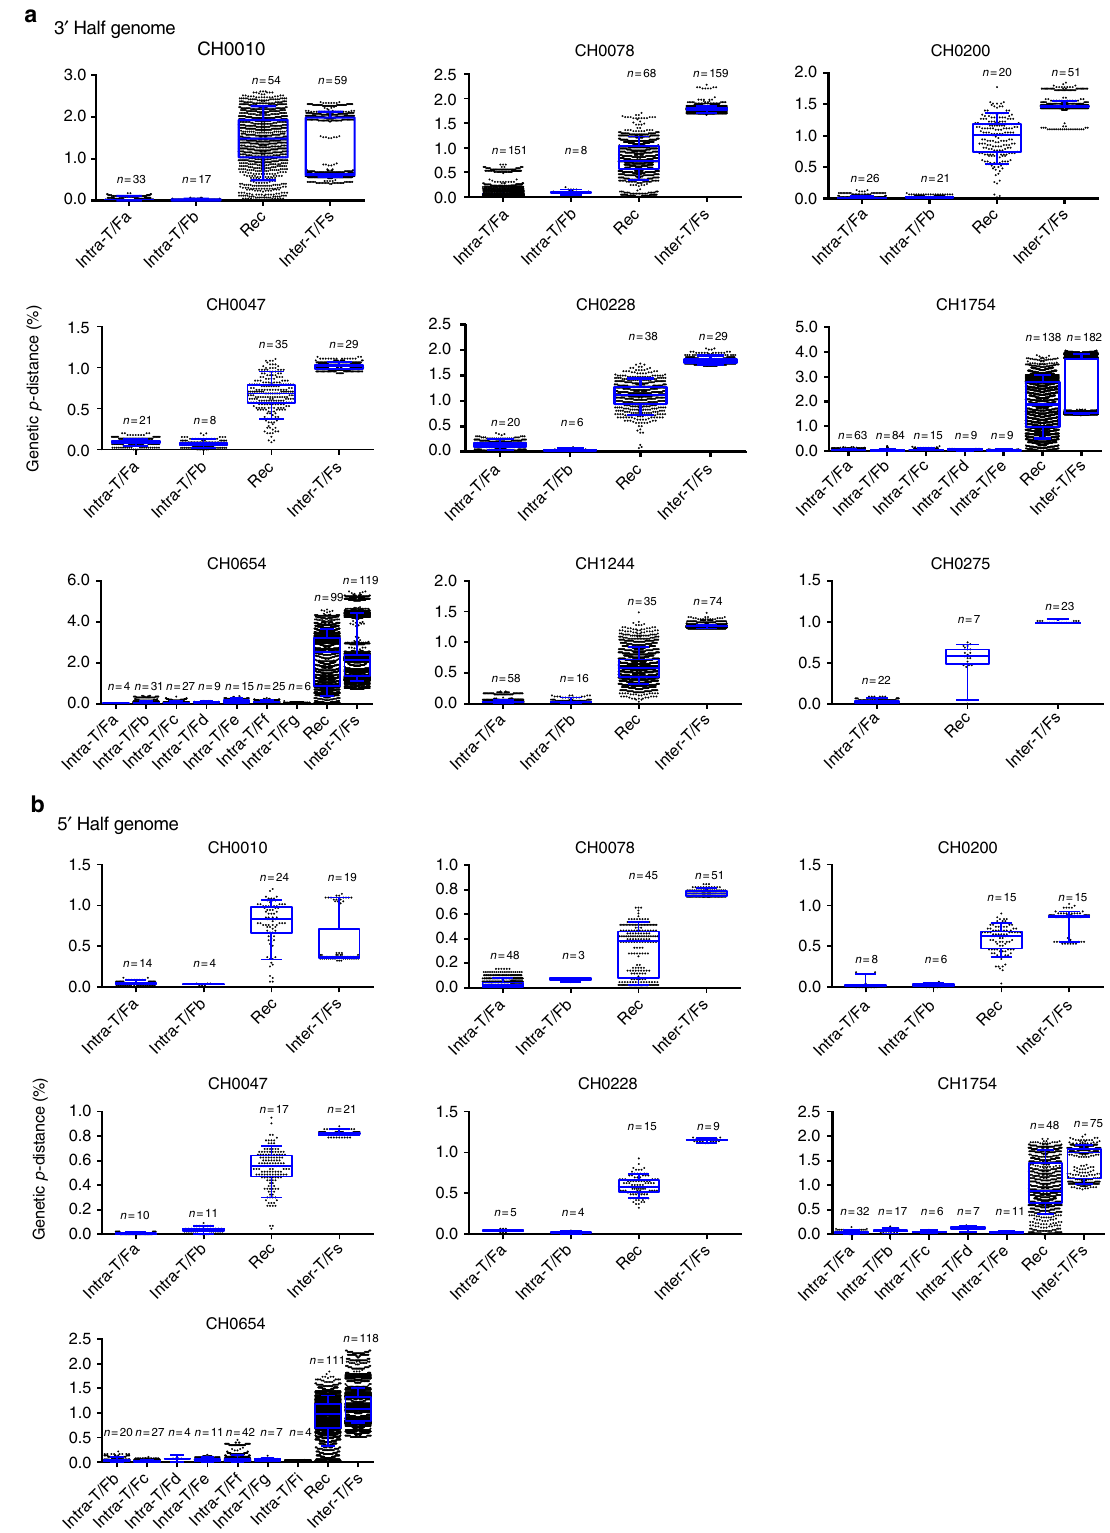
Fig. 7 Genetic p -distances within lineages, inter-lineages, and within recombinants. Pairwise genetic distances ( p -distance) were calculated among recombinant viruses, variants evolved from the same T/F virus (intra-T/F), as well as variants from different T/F viruses (inter-T/F) for 3 ′ half ( a ) and 5 ′ half ( b ) genomes. For intra-T/F diversity, T/F lineages with less than three sequences were excluded. Pairwise genetic distances are shown in black dots, and their means in blue lines. All data were calculated by combining the viral sequences from all time points up to the time that all of the viruses were recombined. The middle line indicates the median of the diversity; the box shows 25 to 75 percentile of the data; and the whisker shows 10 to 90 percentile of the data. The number of sequences for each pairwise comparison group is indicated at the top of the